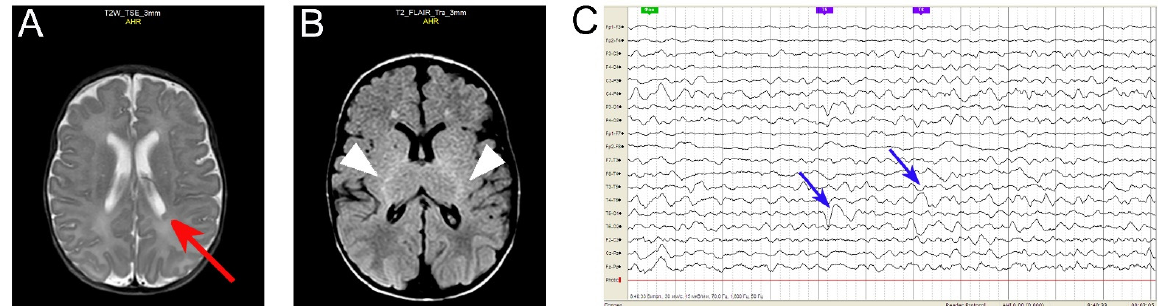
Figure 1. Brain MRI and EEG of the GNAO1 Gln52Arg patient. ( A , B ) Brain MRI (( A ): axial T2 weighted sequence, ( B ): axial FLAIR) reveal left posterior periventricular nodular heterotopia (PVNH, arrow in ( A )) and hyperintensity of the posterior limb internal capsulae (arrowheads in ( B )). ( C ) EEG reveals left posterior temporoparietal slowdowns (arrows).